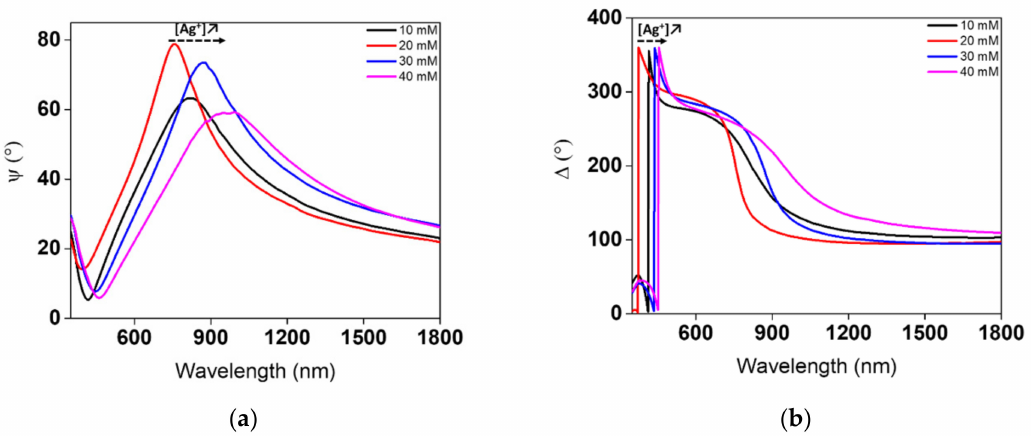
Figure 8. Variations of experimental ellipsometric angles ( a ) Ψ and ( b ) ∆ in AgNPs/PMMA film/c-Si structures, as functions of the concentration of the Ag